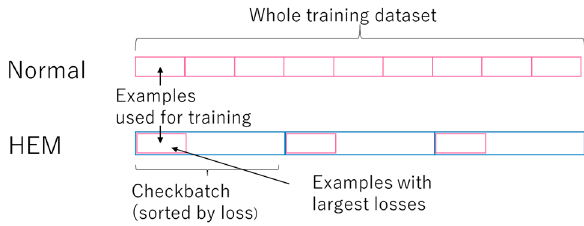
Figure 7. Algorithm overview. Loss values are calculated in each checkbatch and only examples with the largest losses are used for training.